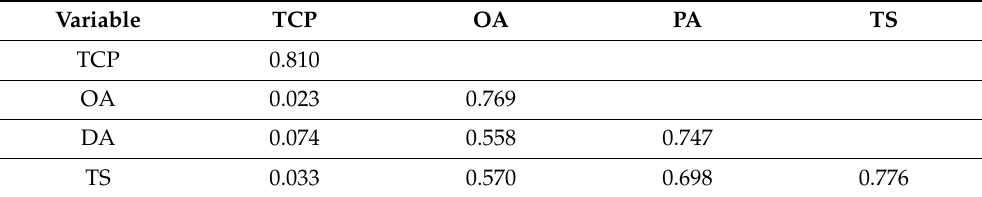
Table 3. The discriminant validity of latent variables.